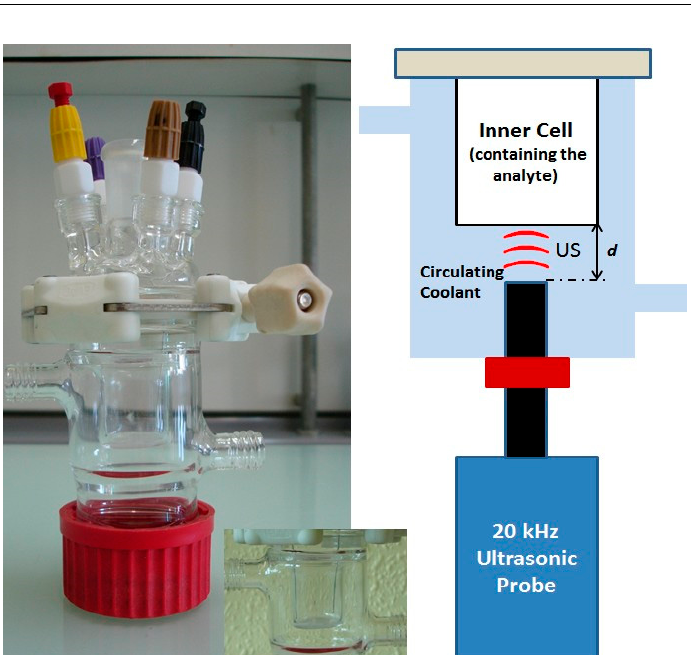
Figure 8. Sonochemical reactor or ‘Sonoreactor’ ( Besançon cell—Professor Jean-Yves Hihn’s Group, Université de Franche-Comté ) to produce PEMFC and PEMWE catalysts.